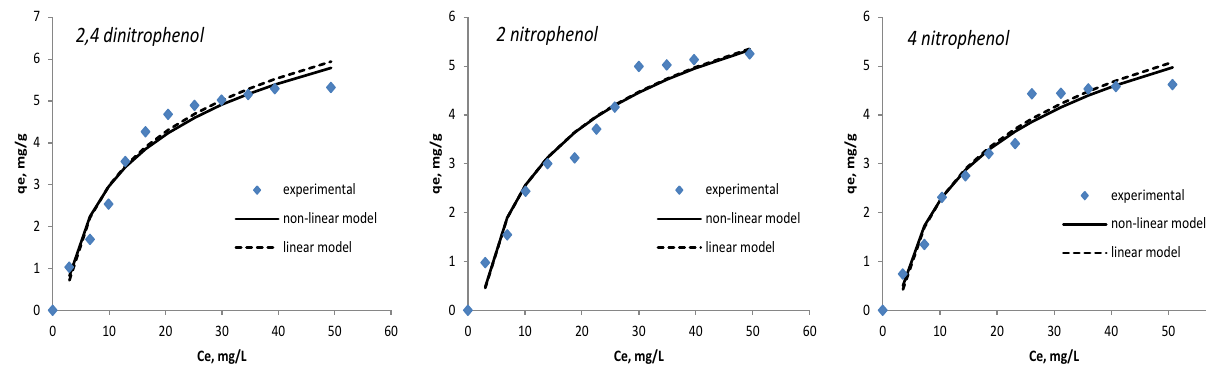
Fig. 6 Fitting of the experimental and model data to Temkin isotherm for adsorption of phenols on char ash